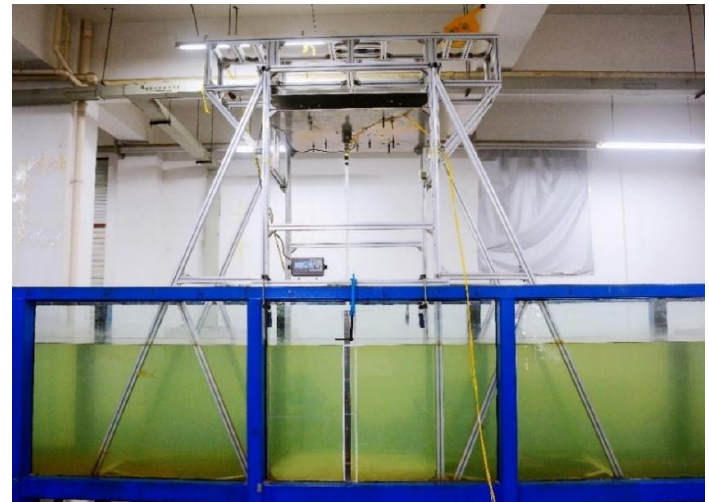
Figure 2. General setup of the experiment ( a ) Top view; ( b ) Elevation view; ( c ) Side view.